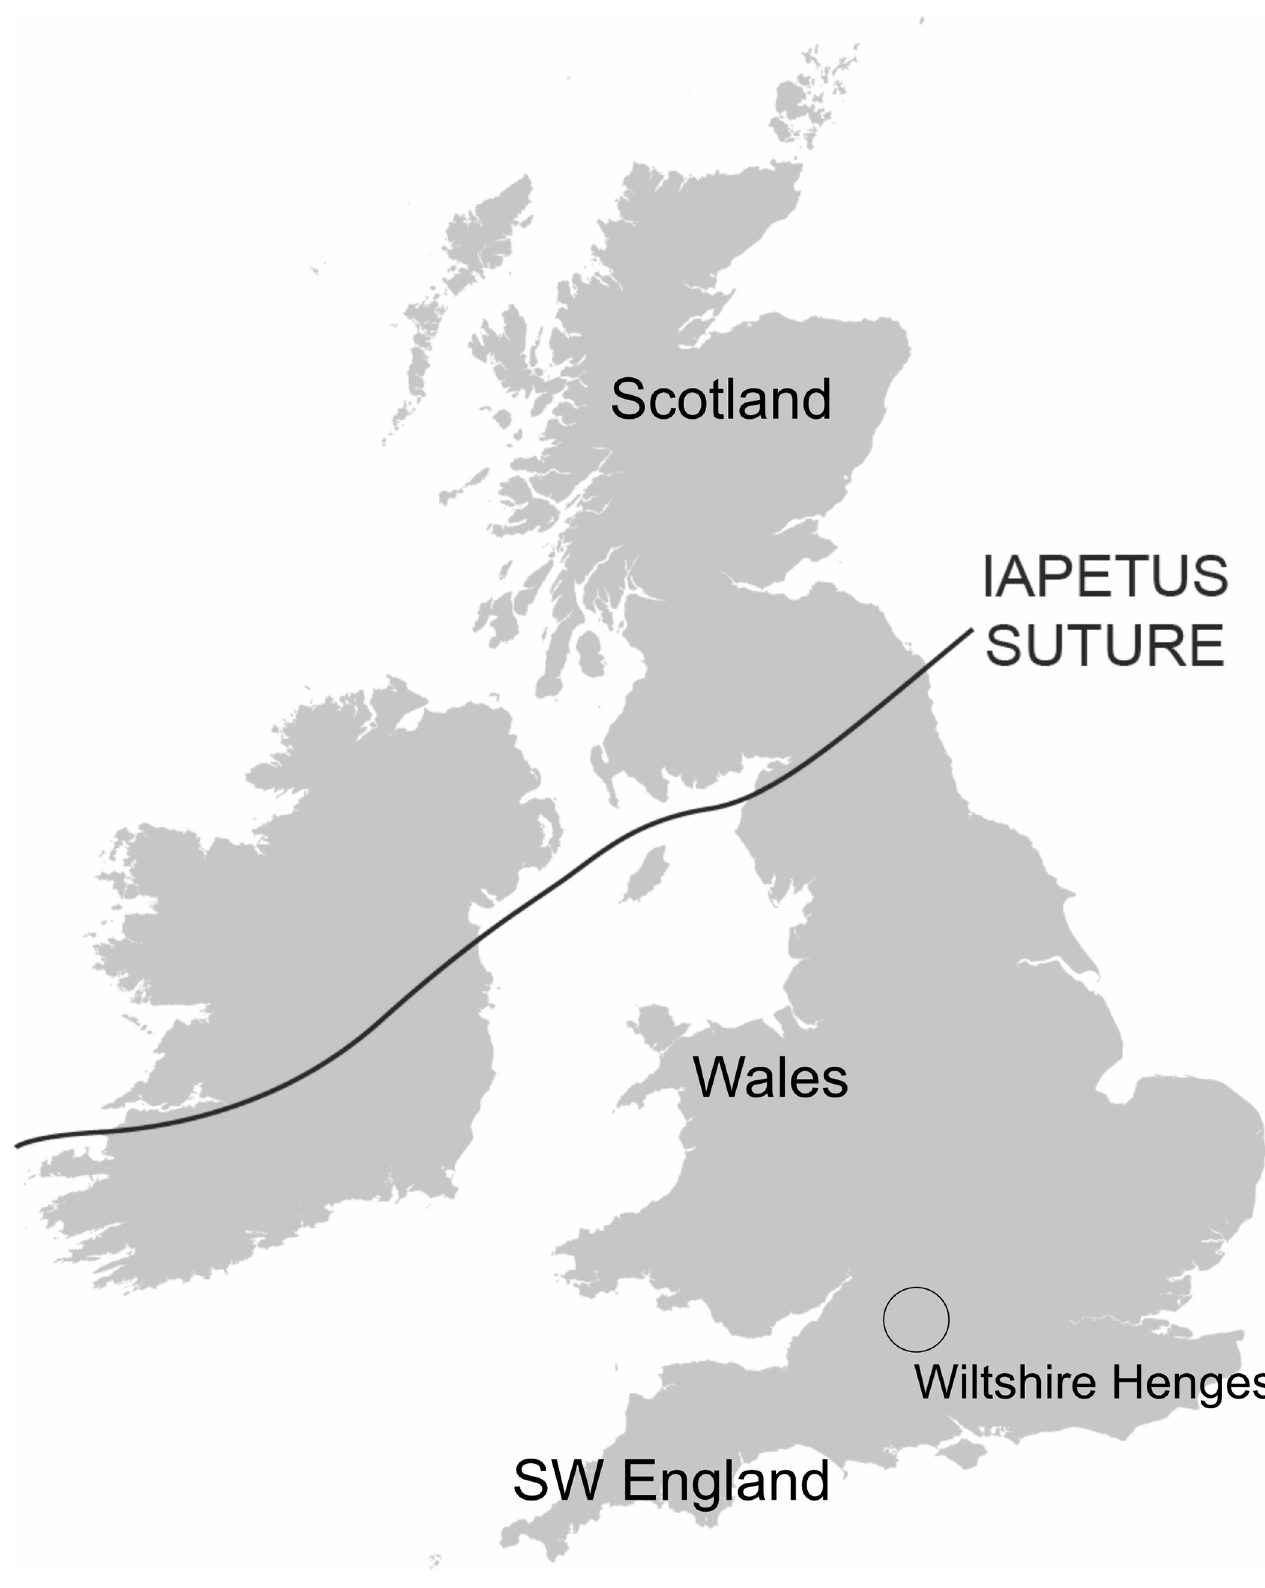
Fig 1. The location of the Iapetus suture. https://doi.org/10.1371/journal.pone.0274831.g001 PLOS ONE | https://doi.org/10.1371/journal.pone.0274831 October 26,